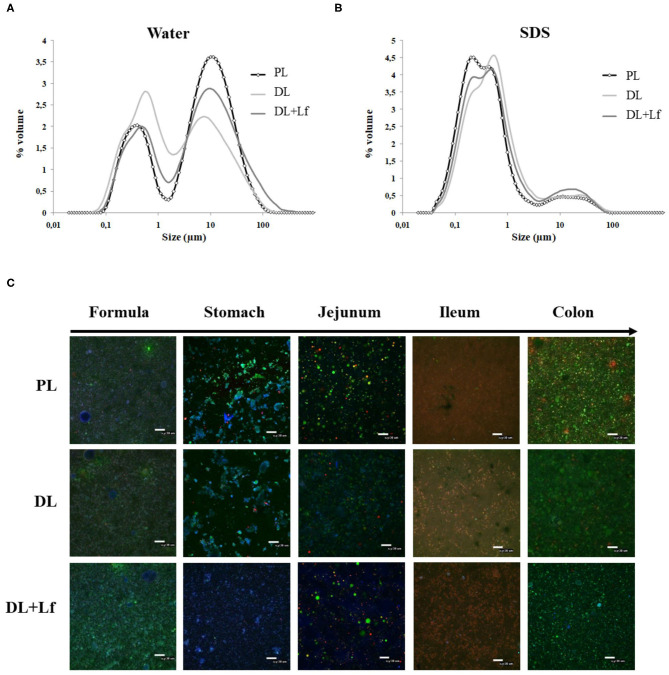
Structural characterization of PL, DL, and DL+Lf formulas. (A,B) Particle size distribution of undigested PL, DL, and DL+Lf formulas determined by laser light scattering in (A) water and (B) SDS. Data represent the mean of three samples, each of them being measured in triplicate. (C) Confocal laser scanning microscopy images (objective ×40 zoom 1) of PL, DL, and DL+Lf undigested formulas and digestive contents from stomach to colon. Apolar lipids are colored in green (Lipidtox®), amphiphilic compounds in red (Rhodamine-PE®), and proteins in blue (fast green). Scale bars = 30 μm. Formulas contained as lipids either only plant lipids (PL), a half-half mixture of plant and dairy lipids (DL), or a half-half mixture of plant and dairy lipids supplemented with Lf (DL+Lf) sulfate.